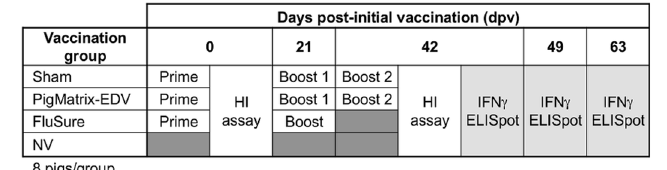
Fig 1. Experimental